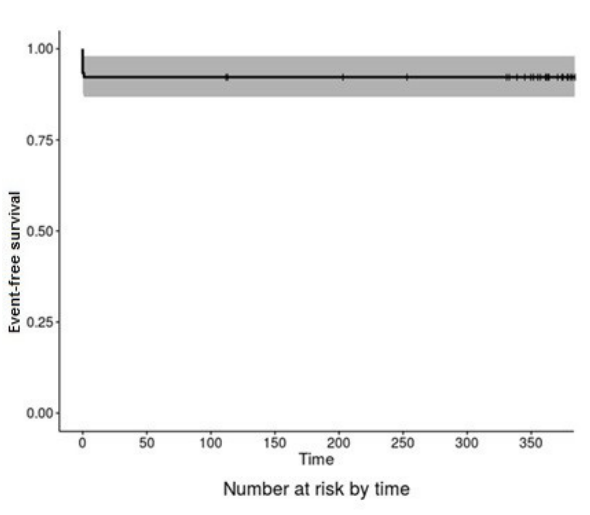
Fig. 5 - Actuarial curve for event-free survival (stroke and death) .